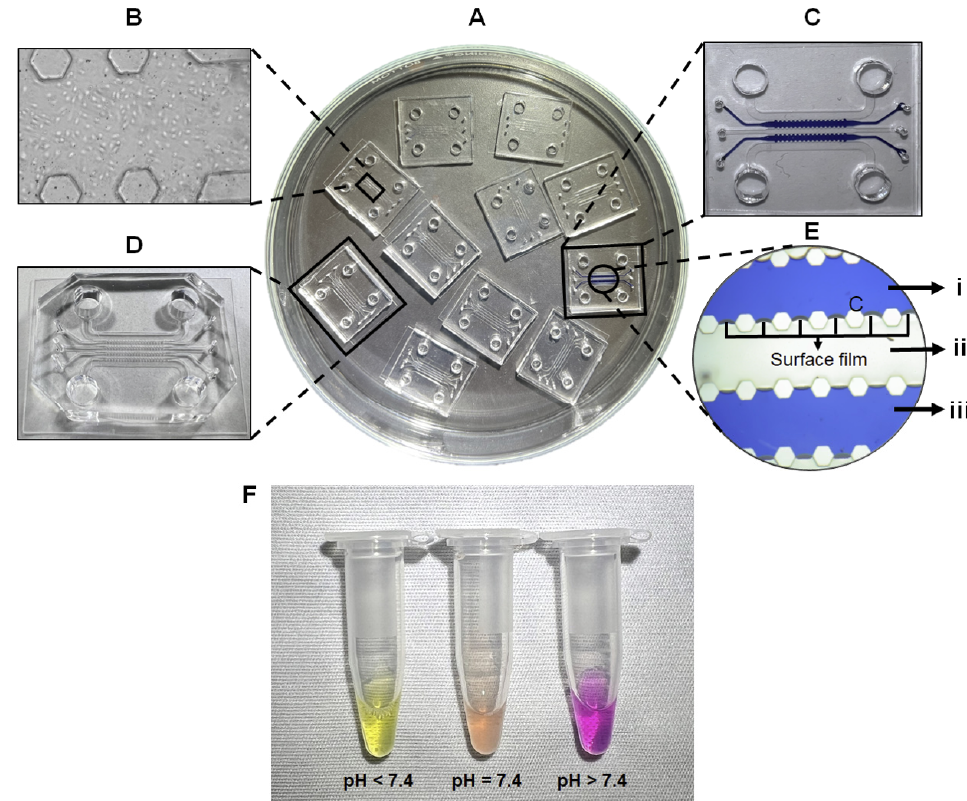
Figure 6. PDMS-based chips—( A ) 11 chips with five channels and hexagonal pillars. ( B ) Pulmonary arterial endothelial cells seeded on the intimal channel of the chip, the second channel from the top in Panel C. ( C ) Leak test performed by passing a trypan blue solution in the intimal and adventitial channels. The solution did not move from its respective channel to the adjacent channel because of surface-film created by air–water surface tension between pillars. ( D ) Zoomed-in view of a PAH- chip. ( E ) Zoomed-in view of Panel C—( i , iii ) The trypan blue solution in the intimal and adventitial channels in Panel C. ( ii ) The medial channel with no trypan blue solution because the inter-pillar air–water surface film prevented the solution from moving from intimal or adventitial channel to the medial channel. ( F ) pH indicator for collagen solution–—f the pH is less than 7.4, the solution will be yellowish in color and if the pH is more than 7.4, the solution will start to turn pink. The goal is to obtain a light peach color which indicates a pH of 7.4 suitable for cell growth.